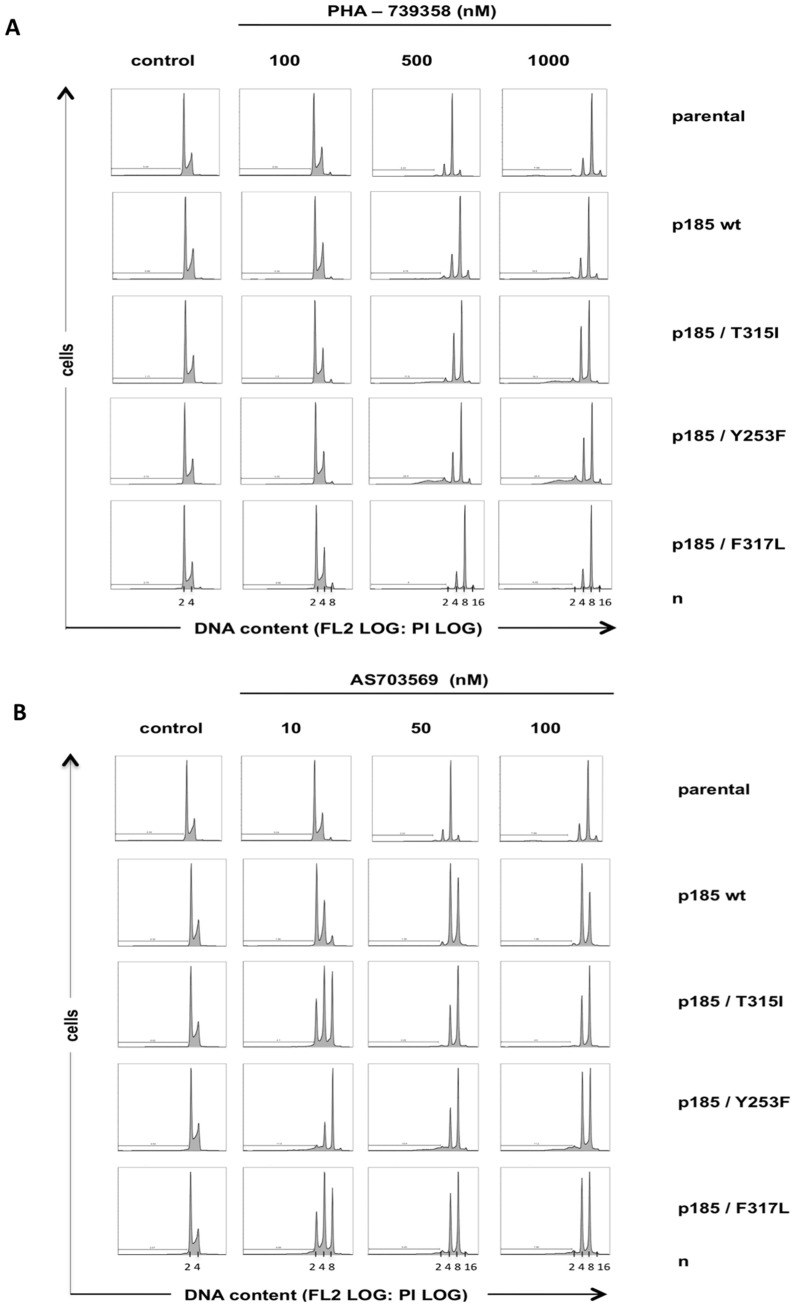
Suppression of Aurora B kinase activity by PHA-739358 or R763/AS703569 inhibits cell division and induces apoptosis in BCR-ABL negative and positive Ba/F3 cells.Ba/F3 and Ba/F3 p185 cells comprising the T315I, Y253F, and F317L mutations were exposed to the indicated concentration of PHA-739358 (A) or R763/AS703569 (B). After 24 h analysis of DNA content and apoptotic fraction of PI-stained cells were assessed by flow cytometry. Untreated cells served as control. Apoptosis was measured as the percentage of cells of sub-G1 DNA content in the FL2 channel in a logarithmic scale.